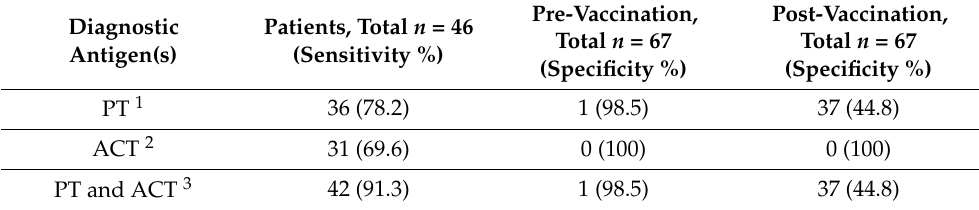
Table 2. Positive results for individual and combinatory Ig antibody test using PT and ACT antigens in patient and vaccination study groups by LF